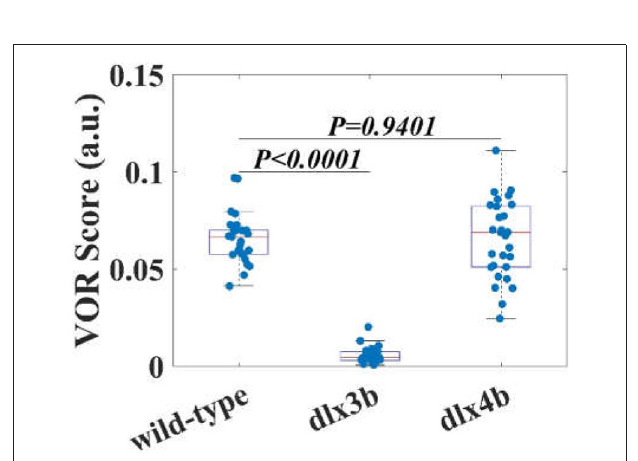
FIGURE 5 | The averaged OKR score of both WT and dlx3b morphant larvae are indifferent. indicating a normal oculomotor and visual neural circuit in dlx3b morphant